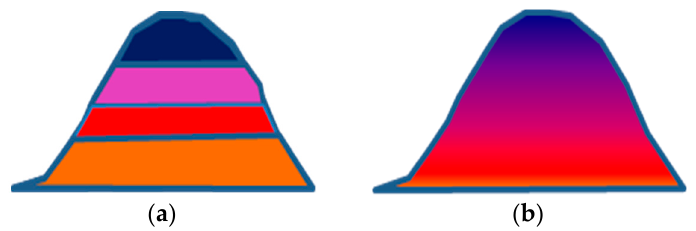
Figure 1. Schematic figures showing hard boundaries with sharp changes between geological domains ( a ) and soft boundaries with transitional changes between geological domains ( b ).